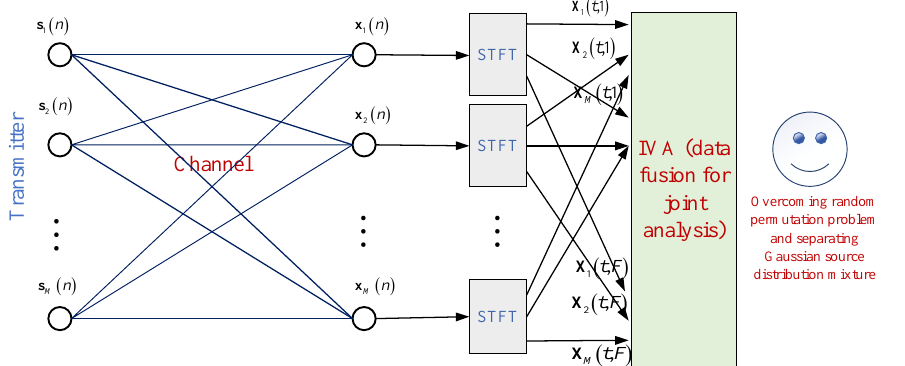
Figure 4. Convolutive mixture model with IVA detection